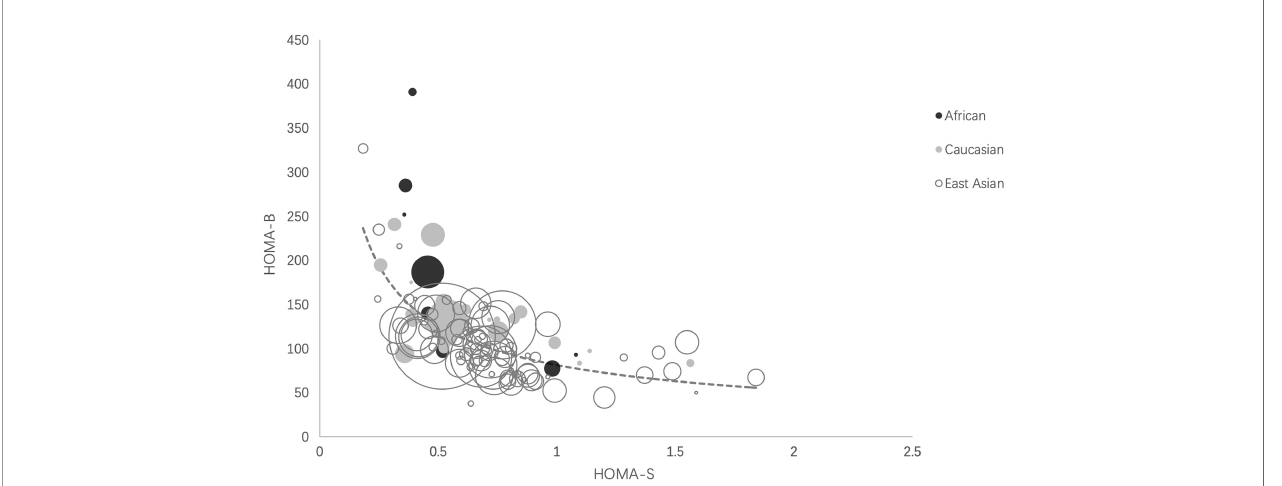
FIGURE 2 | Ethnic distributions of HOMA-B relative to HOMA-S. The scatter plot re fl ects the hyperbolic relationship between HOMA-B and HOMA-S across African, Caucasian, and East Asian cohorts. Each circle indicates one cohort and the circle area is proportional to sample size of the cohort. The curve was calculated as ln (HOMA-B) = − 0.626 ln (HOMA-S) + 4.399 by liner regression analysis. HOMA-S, homeostasis model assessment-insulin sensitivity; HOMA-B, homeostasis model assessment- b -cell function.